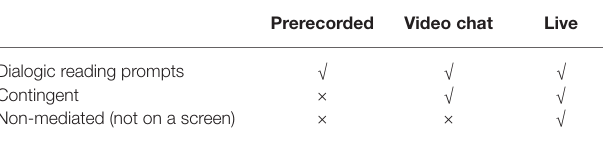
TABLE 1 | Outline of condition affordances. Prerecorded Video chat Live Dialogic reading